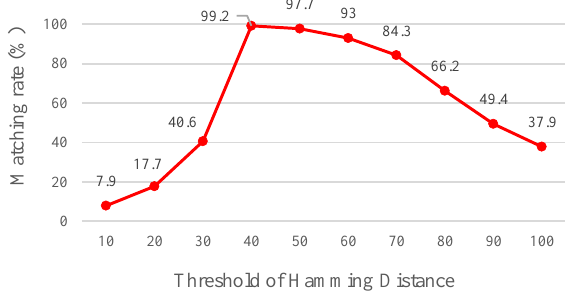
Figure 13. Matching rate under various Hamming distance threshold values.